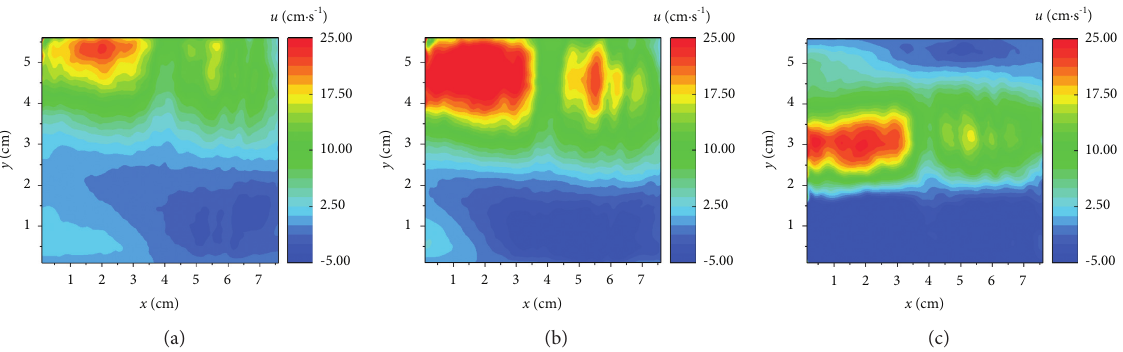
Figure 3: The distribution of the time-averaged longitudinal velocity in different working conditions. (a) B25S. (b) B25M. (c)